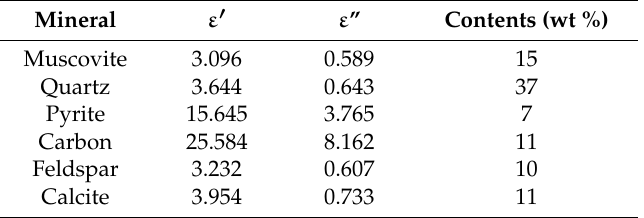
Figure 1. The SEM-EDS results of the minerals before leaching: ( a ) muscovite; ( b ) quartz; ( c ) pyrite. Table 1. Main chemical composition of the black shale (wt %). The capacity of different microwave absorbents to be heated can be measured and compared using the dielectric properties. In Table 2, the relative dielectric constant ( ε (cid:48) ) and dielectric loss factor ( ε ”) are used to express the dielectric response of materials in the microwave field [24]. The dielectric constant measures the ability of a material to store microwave energy, i.e., the ability of the material to be polarized. The loss factor measures the ability of a material to dissipate the stored energy into heat [25]. Table 2. Major mineral constituents and dielectric property ( ε (cid:48) , ε ”) in black